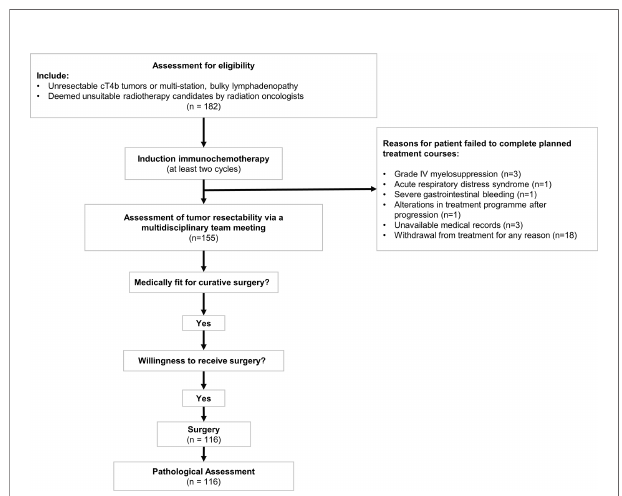
FIGURE 1 | Flowchart of the induction treatment course for initially unresectable esophageal squamous cell carcinoma patients. Patients who met the inclusion criteria received at least two cycles of immunochemotherapy. Patients who failed to complete planned cycles of treatment were excluded from the subsequent analysis. Assessment of tumor response was conducted via a multidisciplinary team meeting. McKeown esophagectomy and Ivor Lewis esophagectomy would be performed on medically fi t individuals with willingness to receive